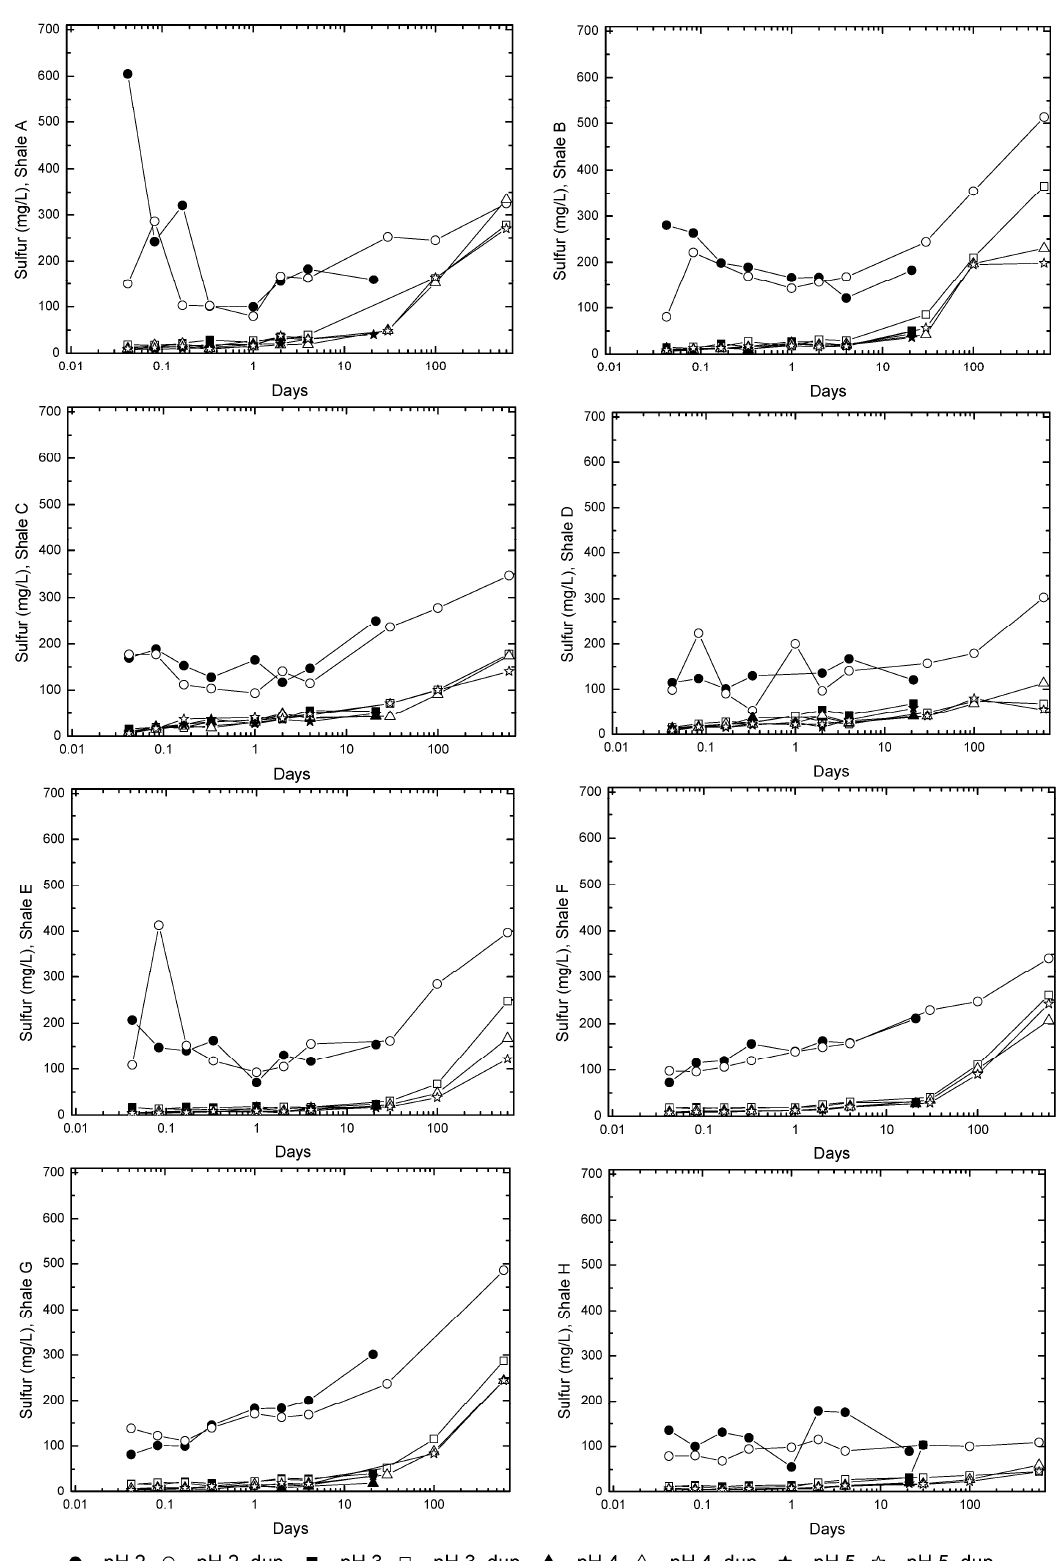
Figure 3. Solution Sulfur concentration recorded over time for all reaction vessels for all samples. Points on lines mark sample intervals from experiment commencement and 1, 2, 3, and 8 h, and 1, 2, 4, 21, 30, 100 and 600 days (logarithmic scale). The legend indicates initial sample